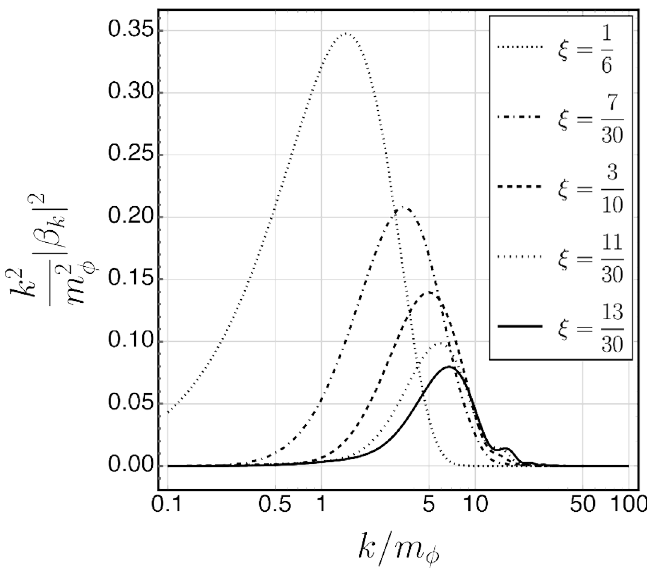
Figure 3 . Representative spectral particle production for masses in the regime m > H 0 . We are showing the particular (cid:12)eld mass m = 1 : 8 (cid:2) 10 13 GeV. In these cases the production diminishes as the coupling term grows as it contributes to the e(cid:11)ective mass during in(cid:13)ation.